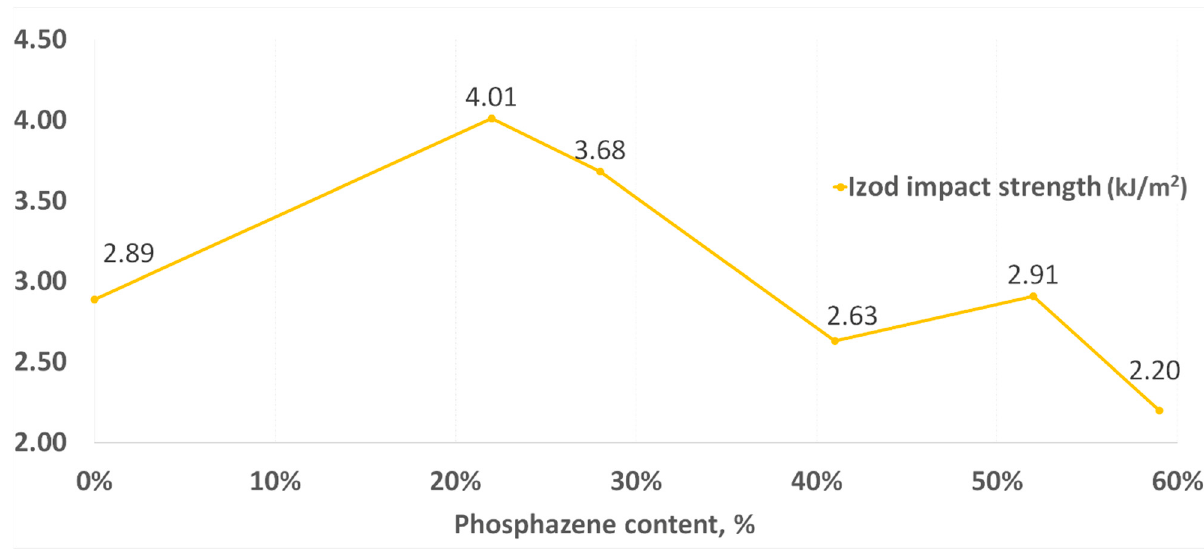
Figure 10. Impact strength according to Izod.